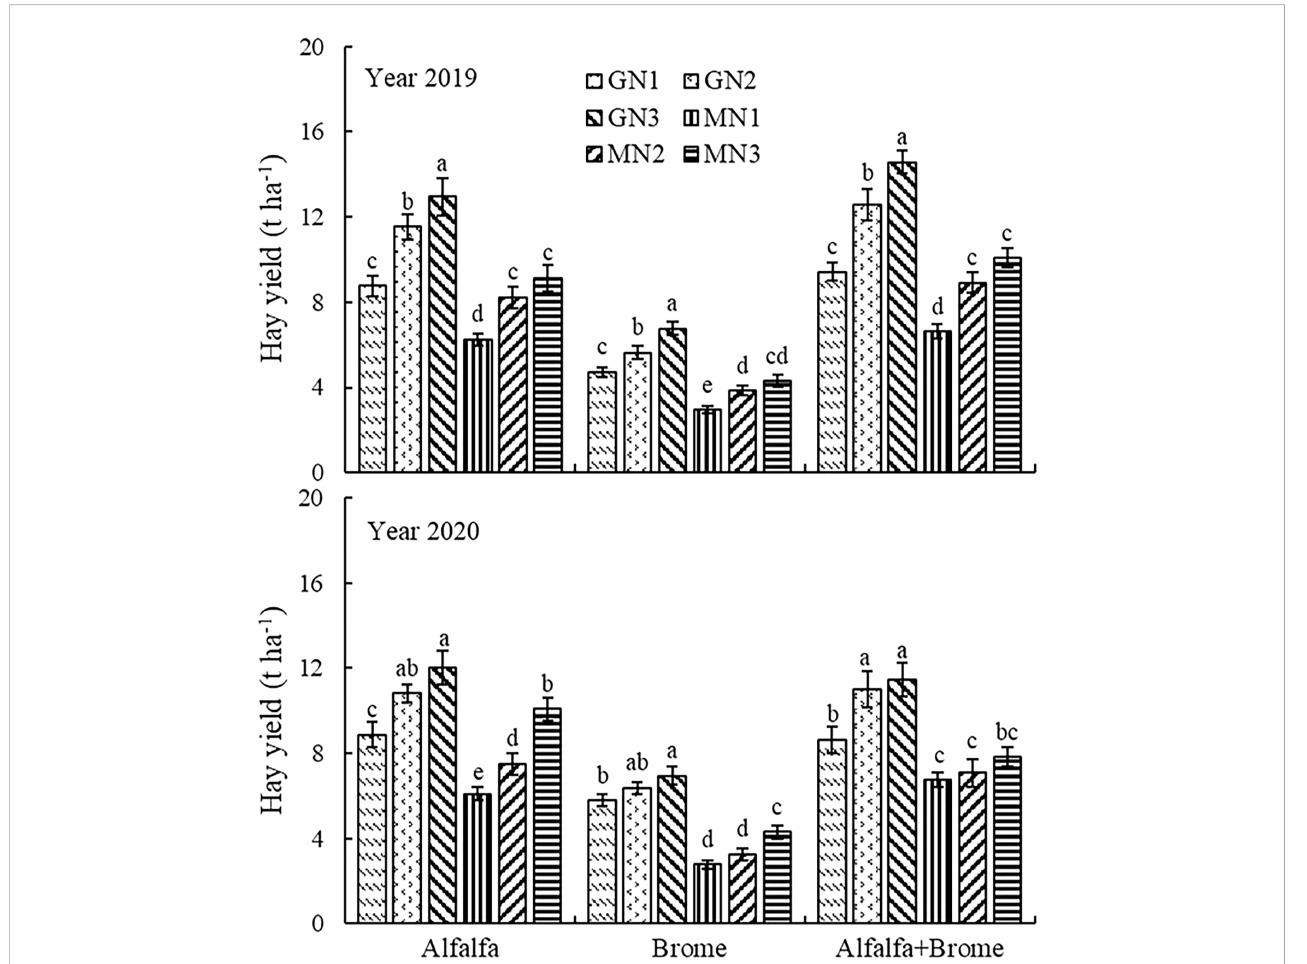
FIGURE 4 Hay yield of pasture under different treatments Note: The different lowercase letters indicate a signi fi cant difference among different treatment at P ≤ 0.05. GT denotes grassland type, MM denotes fi eld management measures, and GT×MM denotes the interaction between grassland type and fi eld management measures. The GN1, GN2, GN3, MN1, MN2, and MN3 treatments indicate no nitrogen application under grazing, 80 kg ha -1 nitrogen application under grazing, 160 kg ha -1 nitrogen application under grazing, no nitrogen application under cutting, 80 kg ha -1 nitrogen application under cutting, and 160 kg ha -1 nitrogen application under cutting,